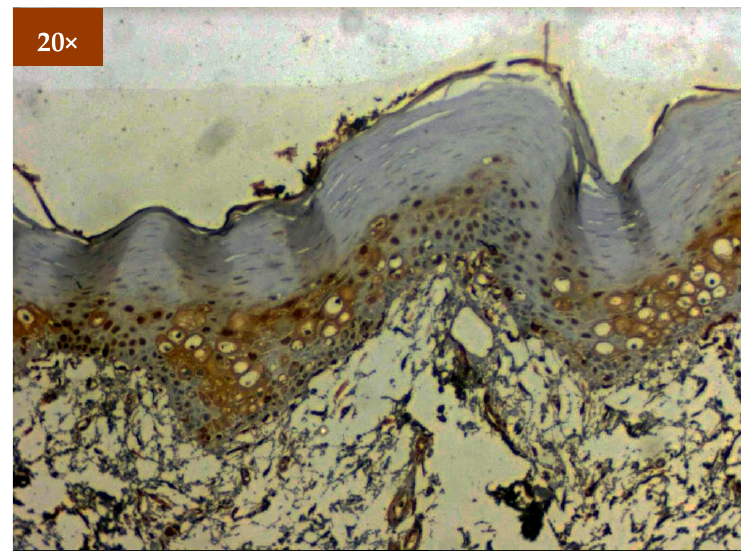
Figure 4. IHC of EGFR in OSMF samples (under 20× magnification) .